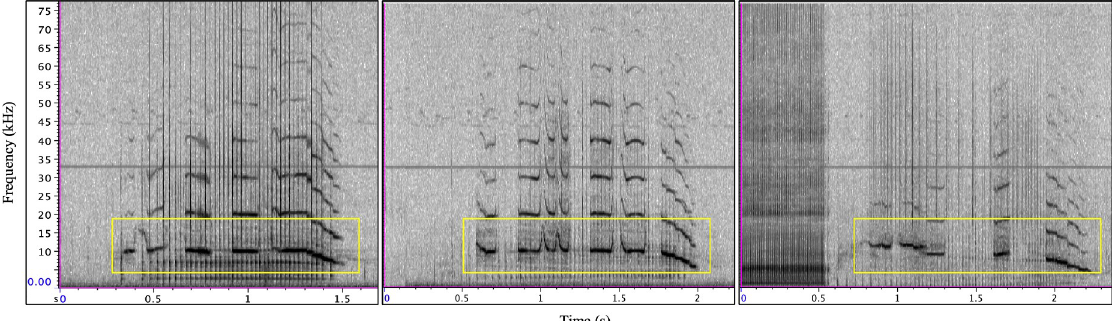
Fig 3. Type C examples from samples used for parameter extraction (n = 7). In all panels, note the upper frequency harmonics, indicative of a signaler facing the Acousonde. In the far right panel, note the end of a type E call (indicated by red asterisk) prior to the beginning of a type C response. Yellow boxes indicate type C overlapping tonal components. Spectrogram parameters: DFT size 512, 256 sample hop size, and Hann window 512